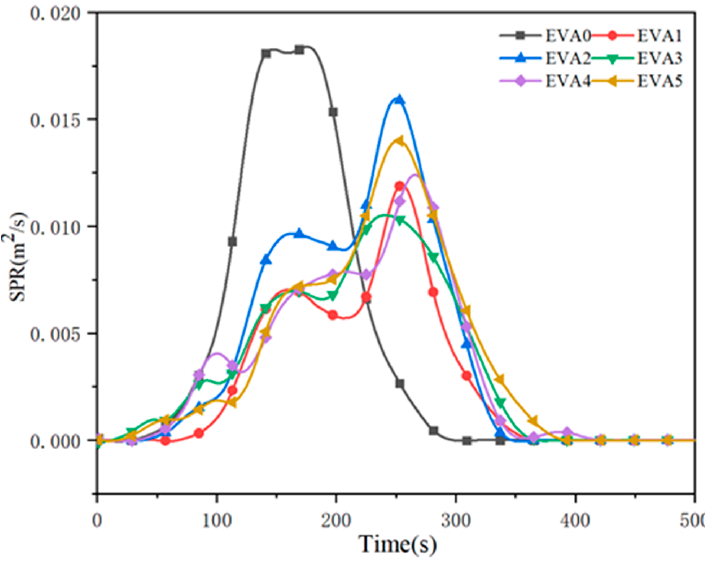
Figure 10. Smoke production rate curves of neat EVA and EVA/MH composites.